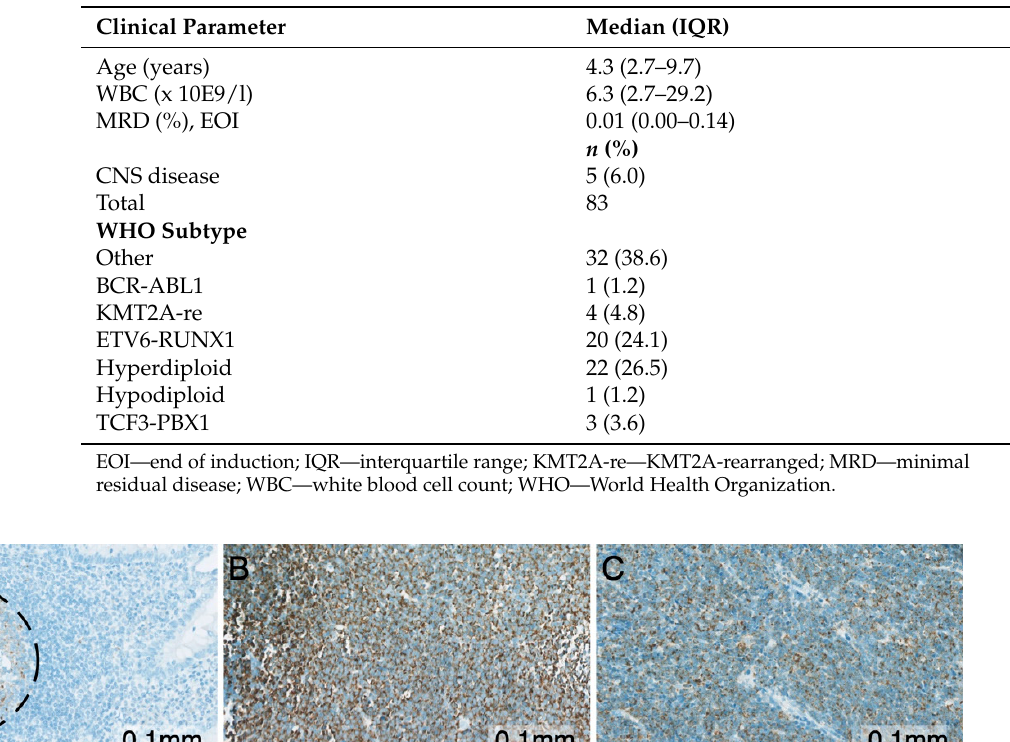
Table 1. Case summary of the tissue microarray (TMA) cohort.